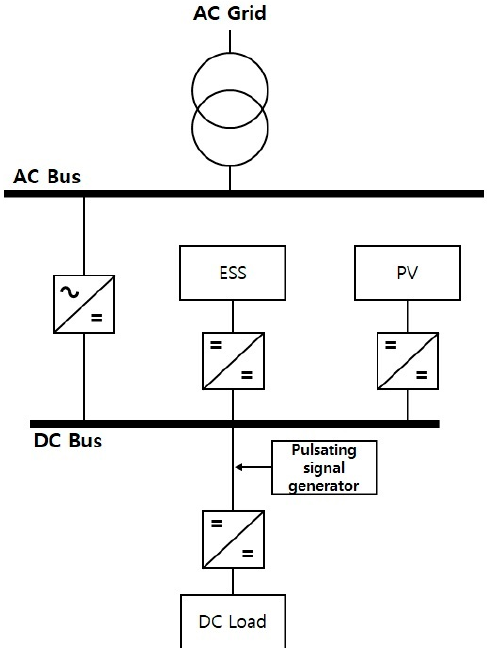
Figure 4. Schematic diagram of an ungrounded low voltage direct current (LVDC) microgrid.